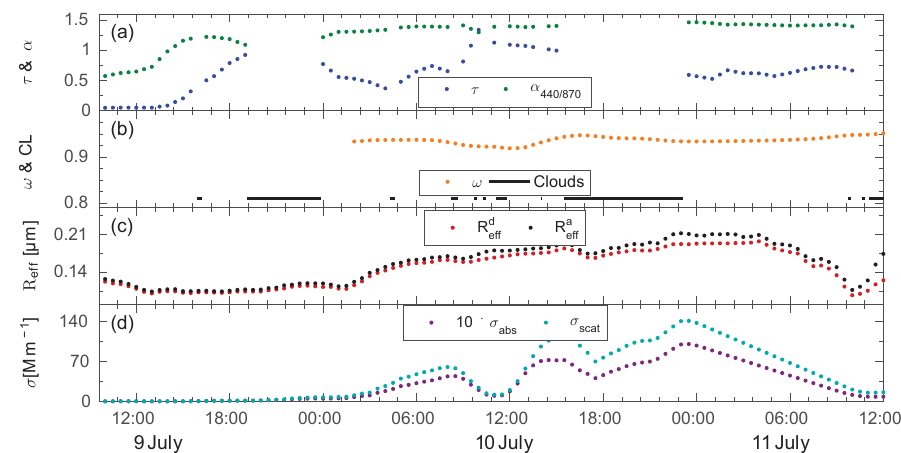
Figure 1. Temporal variability in aerosol single-scattering properties during the BB2015 event over Ny-Ålesund, in particular aerosol optical depth τ at 530nm (blue dots) and Ångstrom exponent α (green dots) measured by SP1a (a) , single-scattering albedo ω d at 530nm (yellow dots) calculated from in situ data and cloud coverage (black line) from the pyranometer (b) , effective radiuses at dry R d ambient R a (black dots) conditions measured by SMPS and APS (c) , and absorption coefficient σ abs multiplied 10 times (purple dots) and eff scattering coefficient σ scat (light blue dots) at 530nm, obtained from the PSAP and